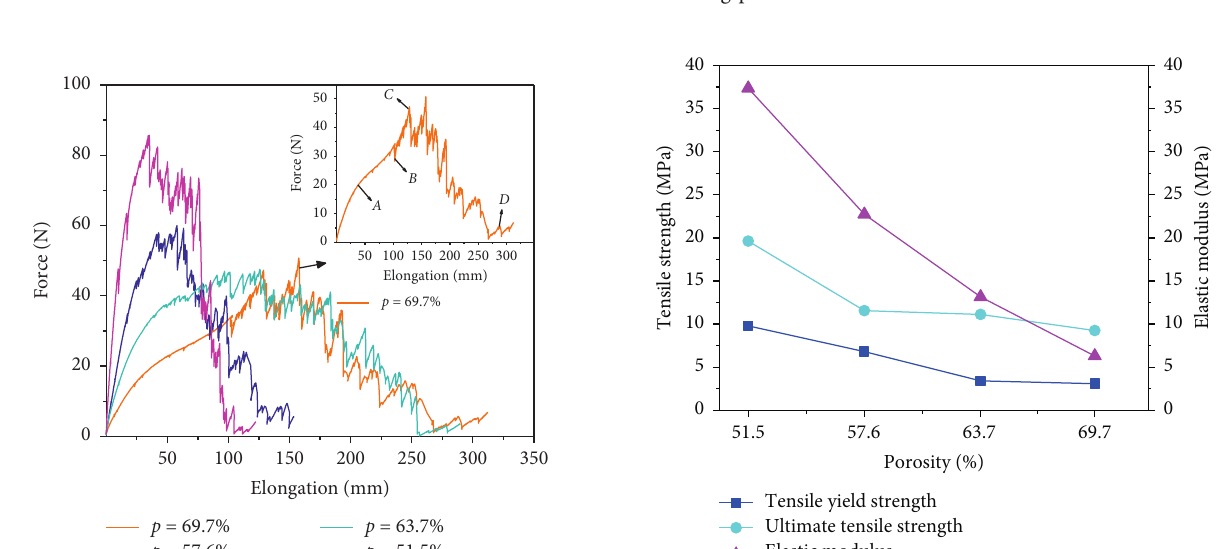
Figure 12: Uniaxial tensile testing process.